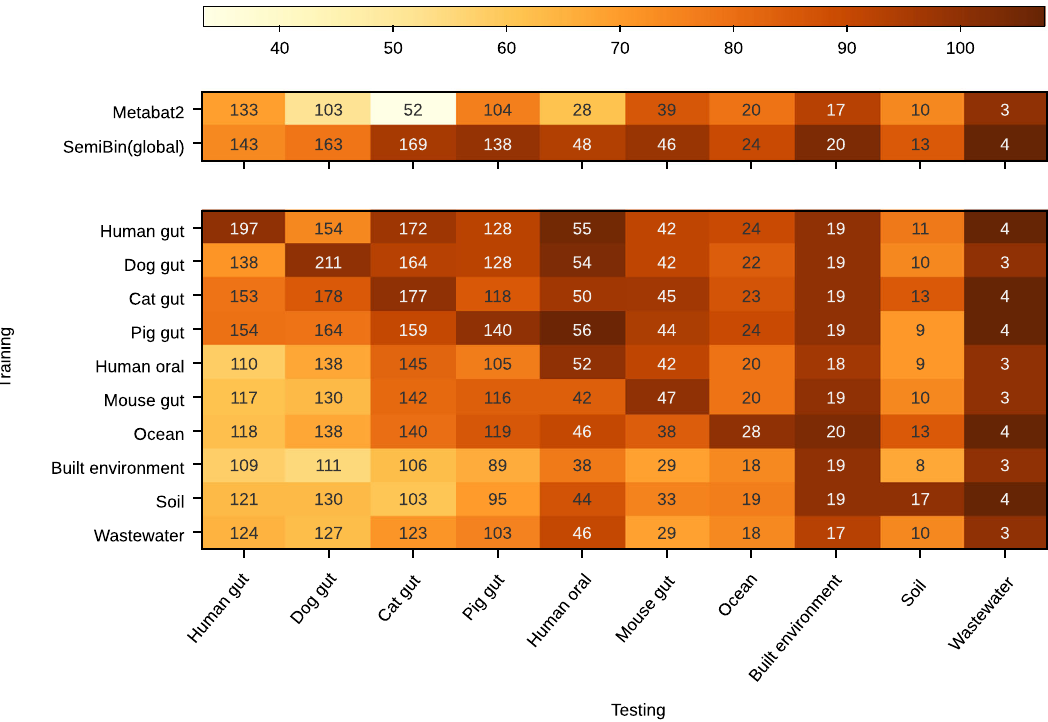
Fig. 5 Habitat-speci fi c models outperform SemiBin(global) which outperforms Metabat2 across 10 environments. We tested every model on the 10 environments (10 testing samples, no overlap with the training samples). We also trained a model from all environments (training from all samples used to generate the pre-trained model for the 10 environments). We termed this model as SemiBin(global). Shown in each cell is the number of high-quality bins obtained from the testing samples, while the color indicates the performance relative to using the model trained in the same environment (a pseudo-count of 10 was added to the raw numbers to smooth the estimates). In most environments, the pre-trained model from the same environment as the testing environment returns the best results. When transferring a model to a different environment, the model can also get good results, and in most situations, it still performs better than Metabat2. In particular, in dog gut, cat gut, and human oral, SemiBin(pretrain) performed better than Metabat2 when training from any